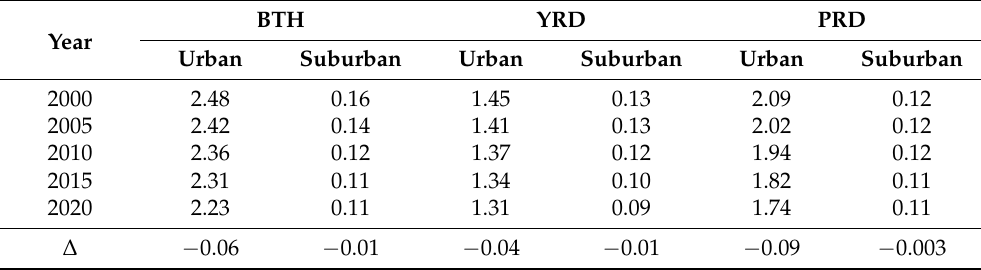
Table 3. Mean PM 2.5 exposure risk in persons per km 2 in urban and suburban areas of BTH, YRD, and PRD and the average change per 5 years during the period